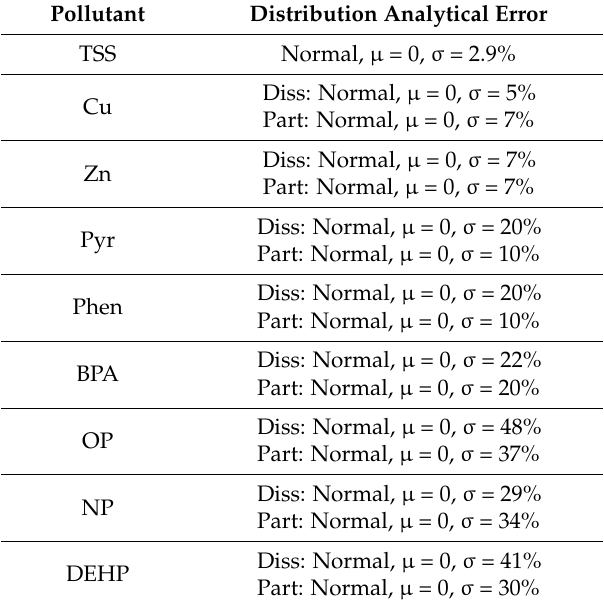
Table B1. Summary of distributions used to account for analytical errors. Table A1. Summary of distributions used to account for analytical